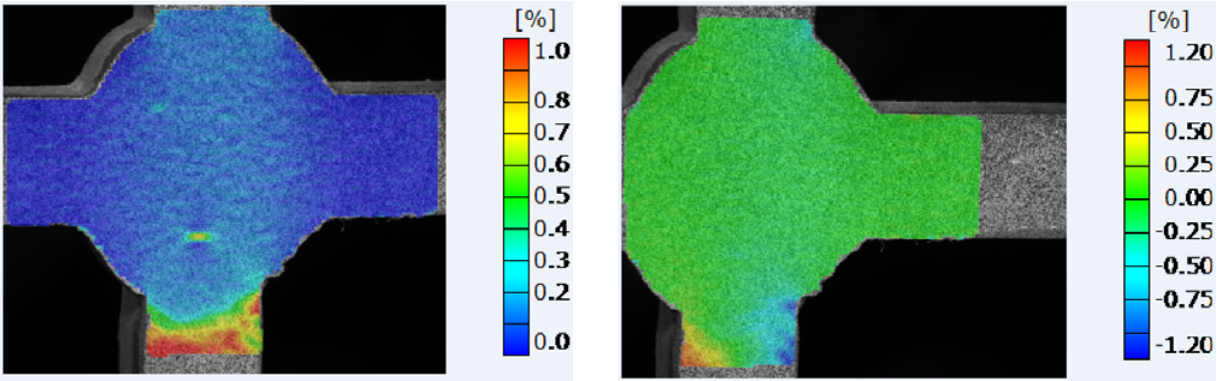
Figure 10: ε x at F max (u x = 1.2 mm). Figure 11: ε x at F min (u x =-1.2